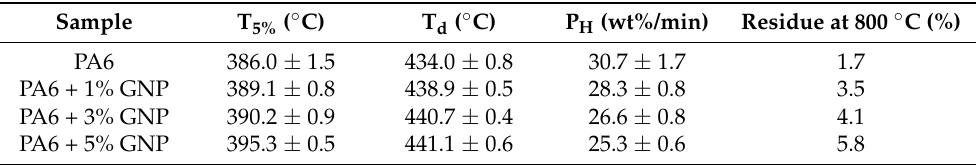
Table 2. Thermogravimetric data.